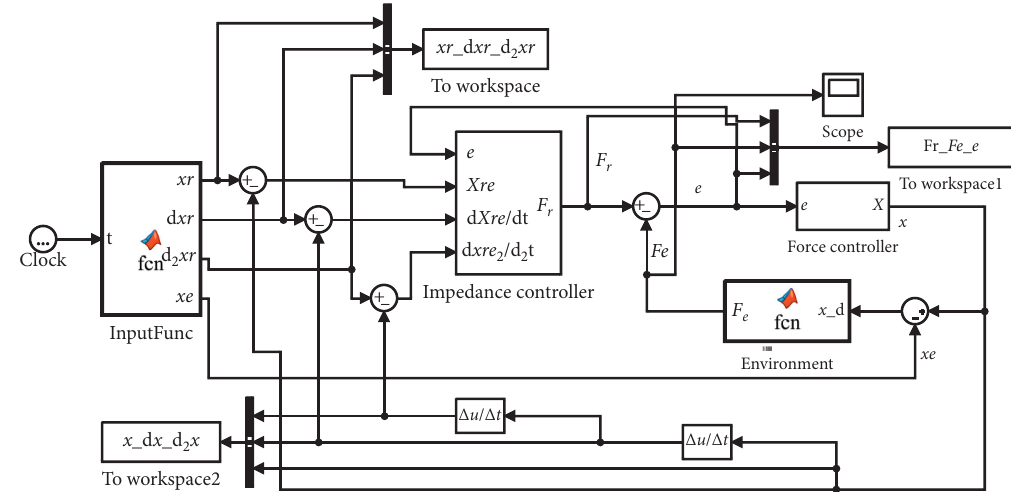
Figure 14: Simulation model of force-based impedance control.